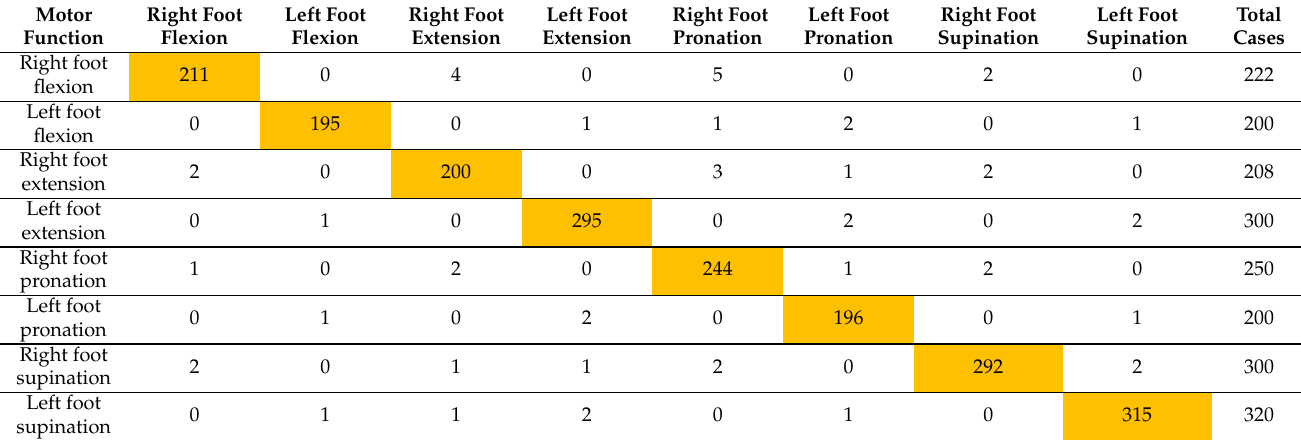
Table 10. Confusion matrix for the proposed DL model with transfer learning with two source domains.